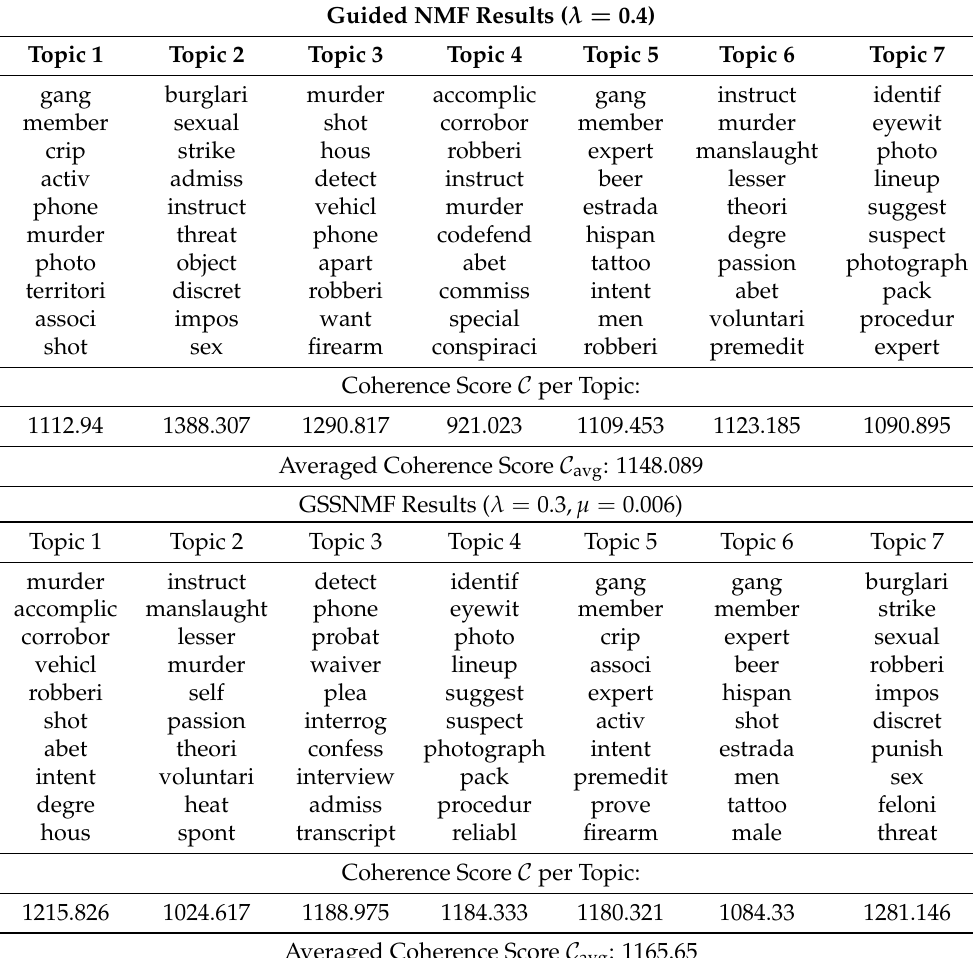
Table 1. Topic modeling results of guided NMF and GSSNMF for Rank 7.